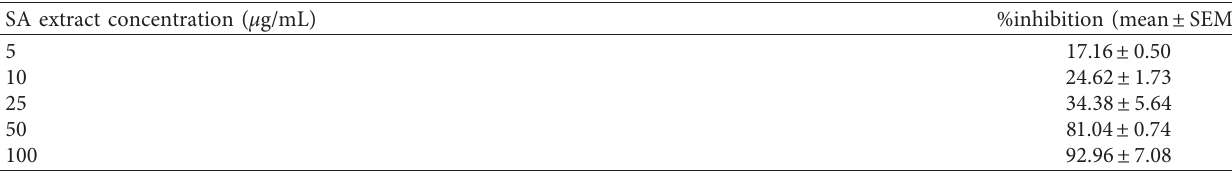
Table 2: Percent inhibition of lipoxygenase activity by the SA extract.